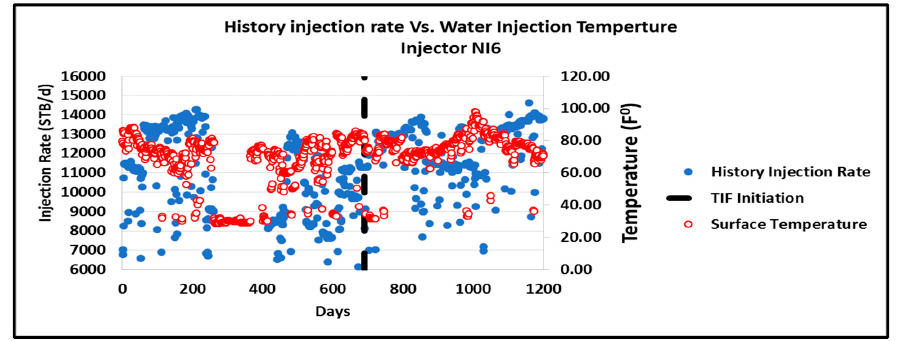
Figure 38. Surface water injection temperature and injection rate correlated after 690 days.